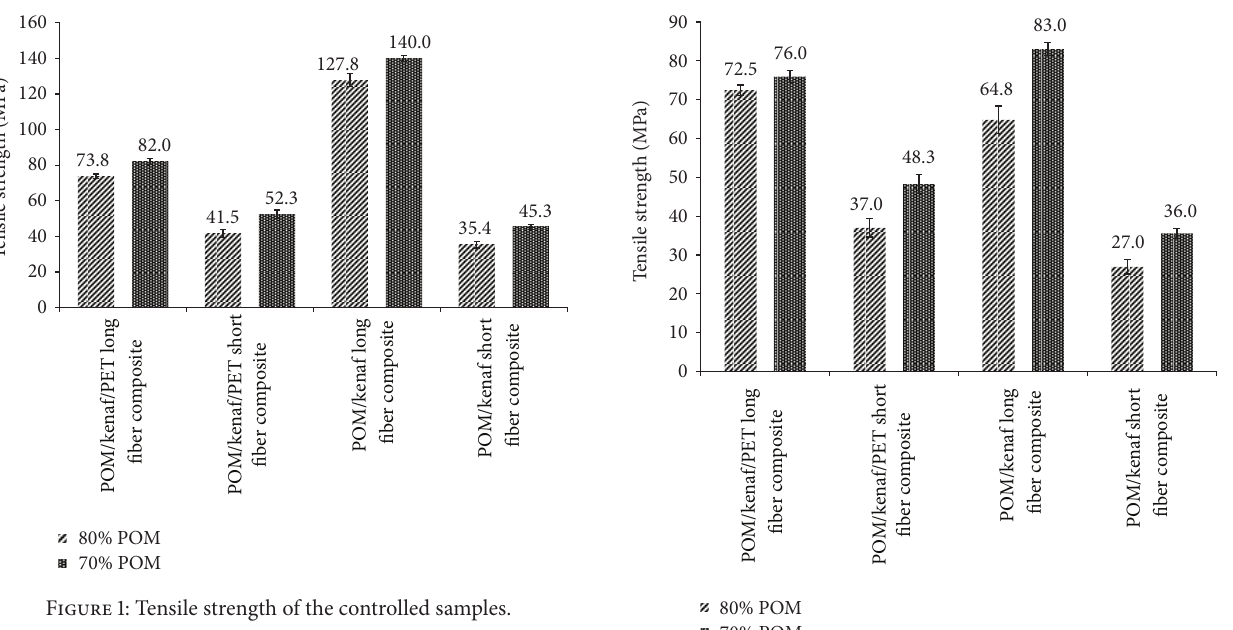
Figure 2: Tensile strength of the weathered